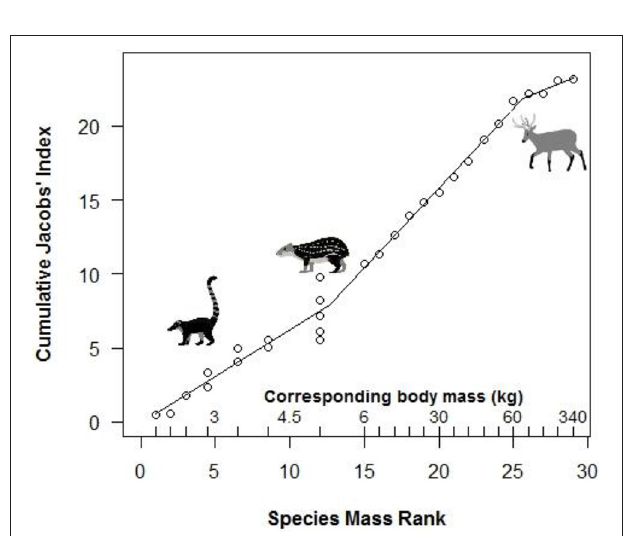
FIGURE 7 | Segmented model of the relationship between the mass rank of each prey species and jaguar preference. Preference is based on cumulative Jacobs’ index values ( + 1 for standardization) following Clements et al. (2014). Actual prey masses corresponding to mass ranks are shown above the x -axis. Representative species sitting at breakpoints are shown (coati, paca, marsh deer).